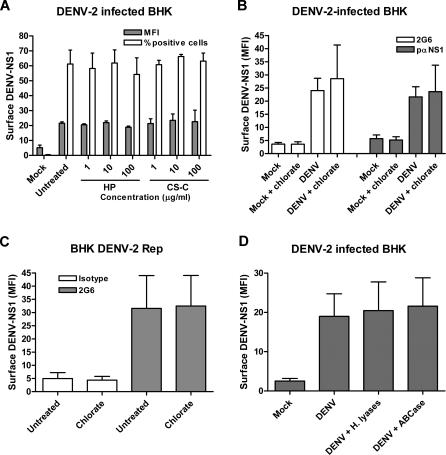
Expression of DENV NS1 on the Surface of Infected Cells Is Not Dependent on GAG(A) BHK cells were infected with DENV-2 at the MOI of 3 and cultured for 24 h in the presence of indicated concentrations of soluble HP or CS-C. Cells were then harvested for analysis of surface NS1 expression.(B) BHK cells were infected with DENV-2 at the MOI of 3 and cultured for 24 h in the presence of 25 mM sodium chlorate. DENV NS1 expression was determined and analyzed by flow cytometry using anti-DENV NS1 mAb (2G6) or polyclonal anti-DENV NS1.(C) BHK DENV-2 Rep cells were cultured in medium containing 25 mM sodium chlorate for 48 h. Expression of NS1 on the cell surface was determined by using anti-DENV NS1 mAb (2G6) and analyzed by flow cytometry.(D) BHK cells were infected with DENV-2 at the MOI of 3. At 24 h after infection, the cells were treated with a mixture of heparin lyases I, II, III (H. lyases) or chondroitinase ABC (ABCase). NS1 expression was analyzed by flow cytometry using the 2G6 anti-DENV NS1 mAb. Data are the mean ± SD of three independent experiments as described in Figure 6.